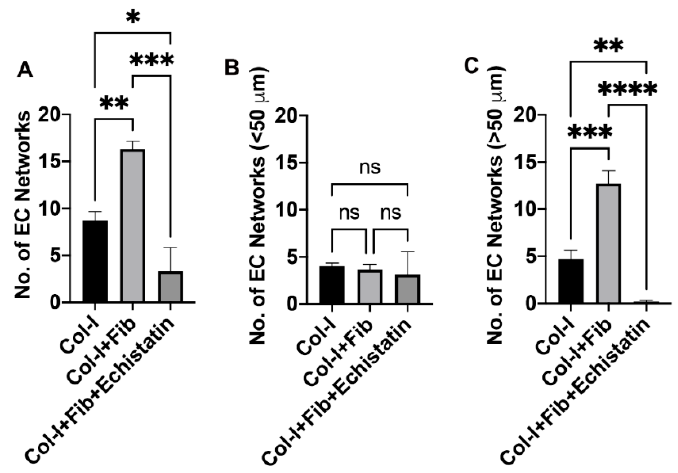
Figure 4. Quantification of EC networks in hiPSC-VSMC and HUVEC hydrogels. The graphs show quantification of ( A ) total number of EC networks, ( B ) networks less than 50 µm, and ( C ) networks more than 50 µm. The different hydrogels were collagen only (Col-I), fibronectin functionalized collagen hydrogel (Col-I + Fib), and Col-I + Fib hydrogel treated with Echistatin (Col-I + Fib + Echistatin). Statistical significance was determined using One-way ANOVA (* p < 0.05; ** p < 0.01; *** p < 0.001; **** p < 0.0001; n = 3).